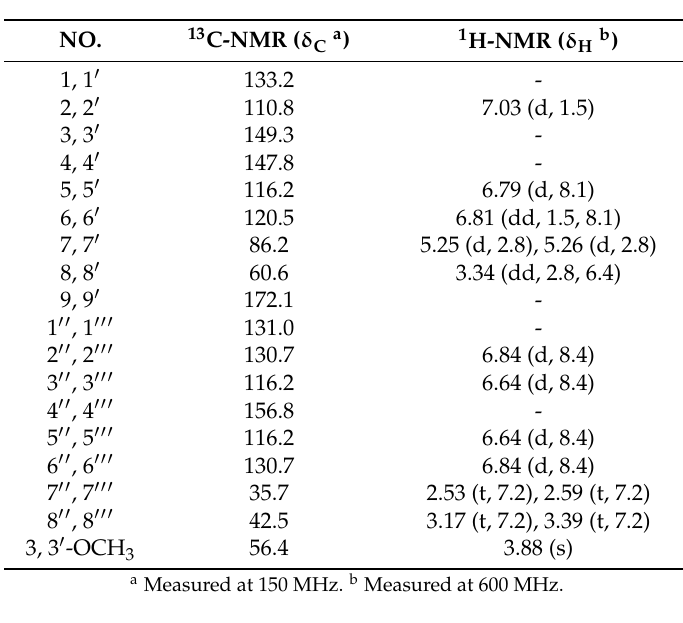
Table 1. 1 H and 13 C-NMR data of compound 1 (CD 3 OD, δ in ppm, J in Hz).